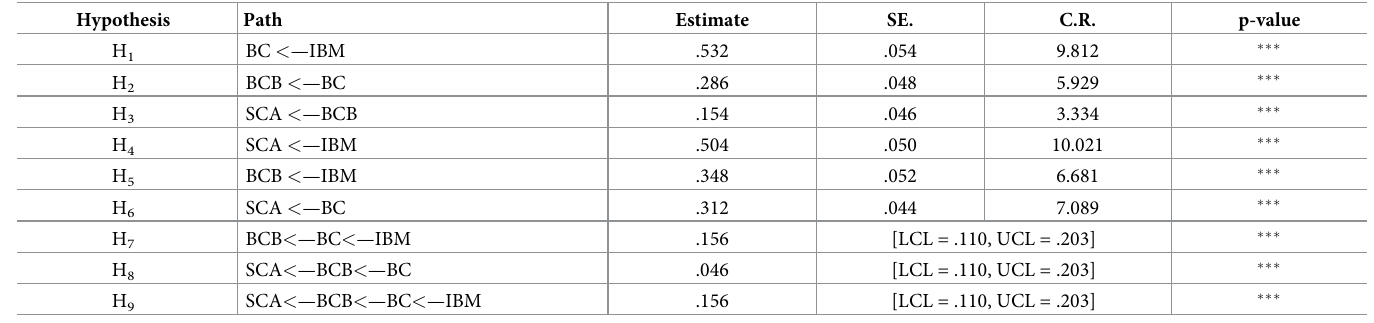
Table 5. Structural model